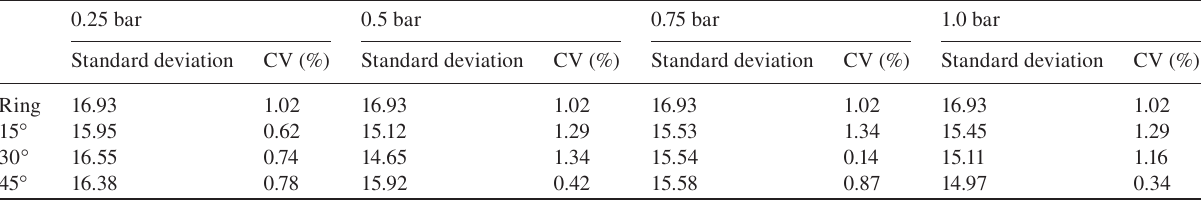
Table 9 Standard deviation and coeffi cient of variation (CV) values of tenacity test results.